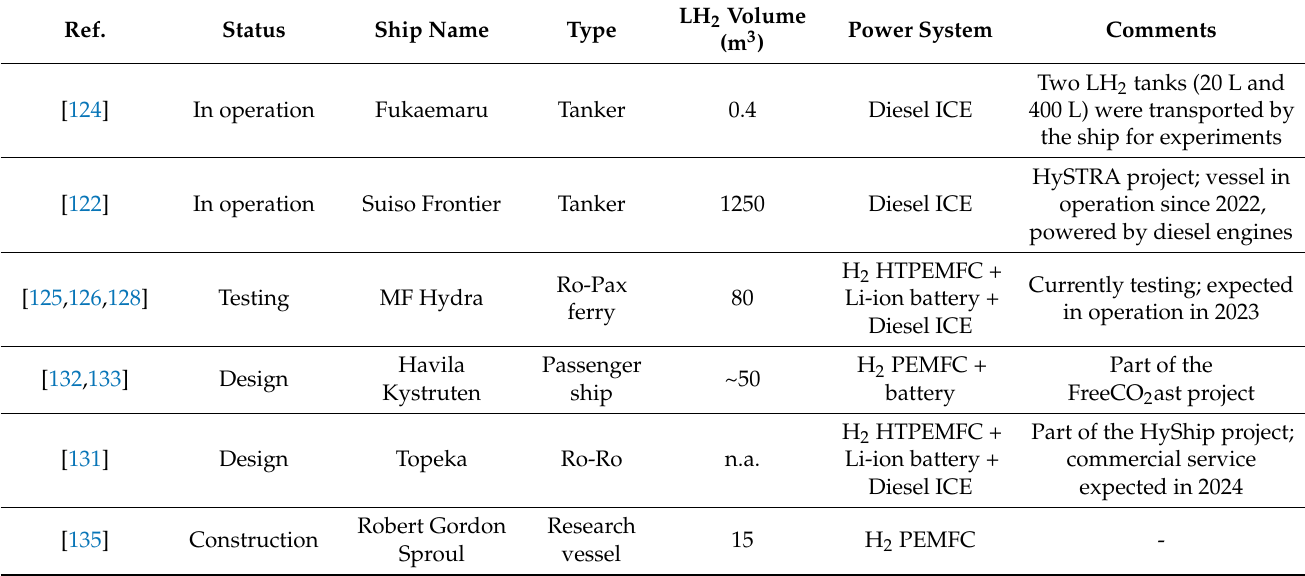
Table 5. LH 2 ships (abbreviation: Ro-Ro: roll-on, roll-off; Pax: passengers, H 2 : hydrogen, ICE: internal combustion engine, PEMFC: polymeric electrolyte membrane fuel cell, n.a.: not available).